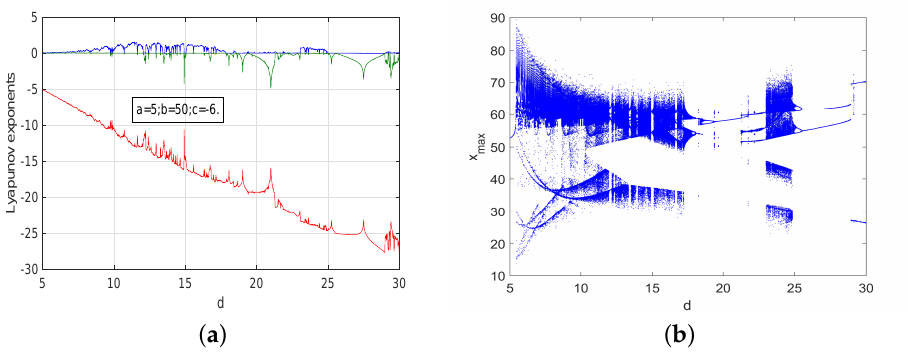
Figure 8. The Lyapunov exponents spectrum and the bifurcation diagram of system (1) with ( a , b , c ) = ( 5,50, − 6 ) and 5 < d < 30 at the initial values ( 50.01,7.31,5.01 ) T : ( a ) Lyapunov exponents; ( b ) bifurcation diagram.